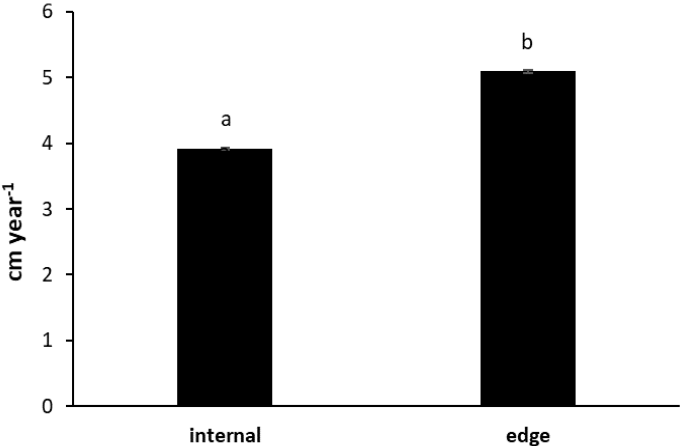
Figure 3. Annual growth rate (cm) measured for interior trees and trees at the edge of plantation C. Values are reported as mean ± s.e. Different letters at the tops of the bars indicate a significant difference among values measured for the plantations.